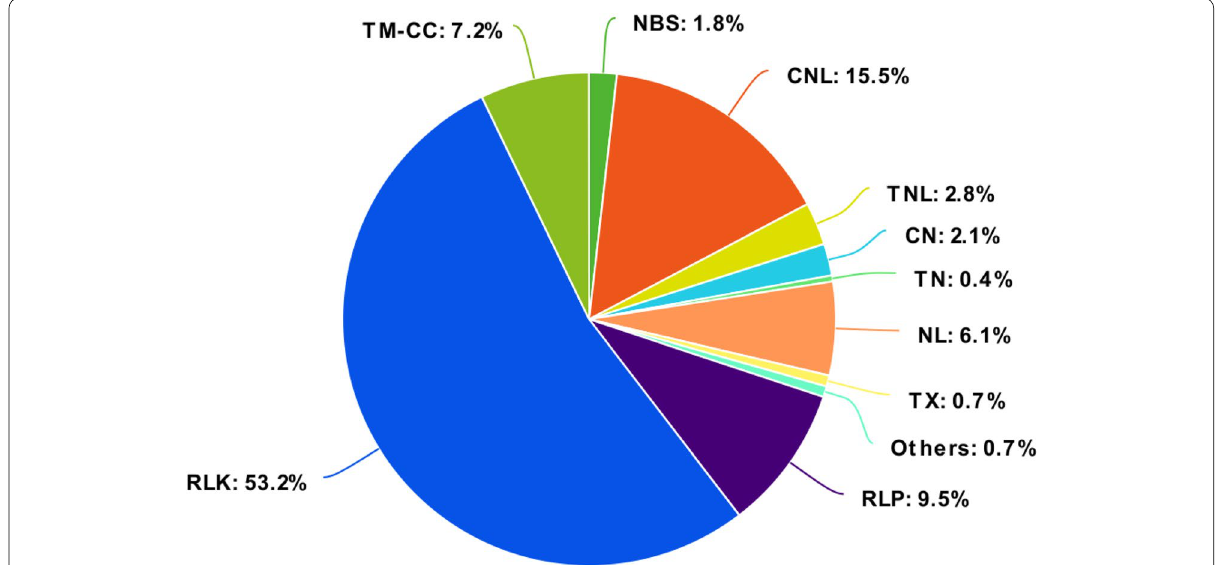
Fig. 1 Percentage and distribution of the classifications based on conserved domains and motifs of genome-wide RGAs of